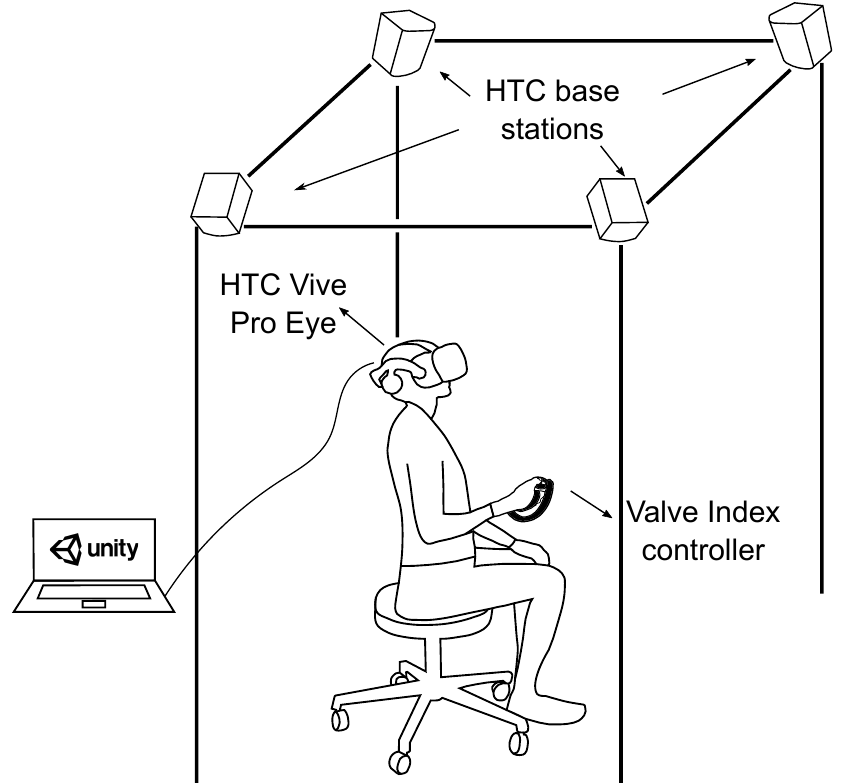
Figure 3. Schematic representation of the experimental setup. To strengthen the immersion, a virtual chair was placed in the VR environment at the same position where the actual chair was located in the real